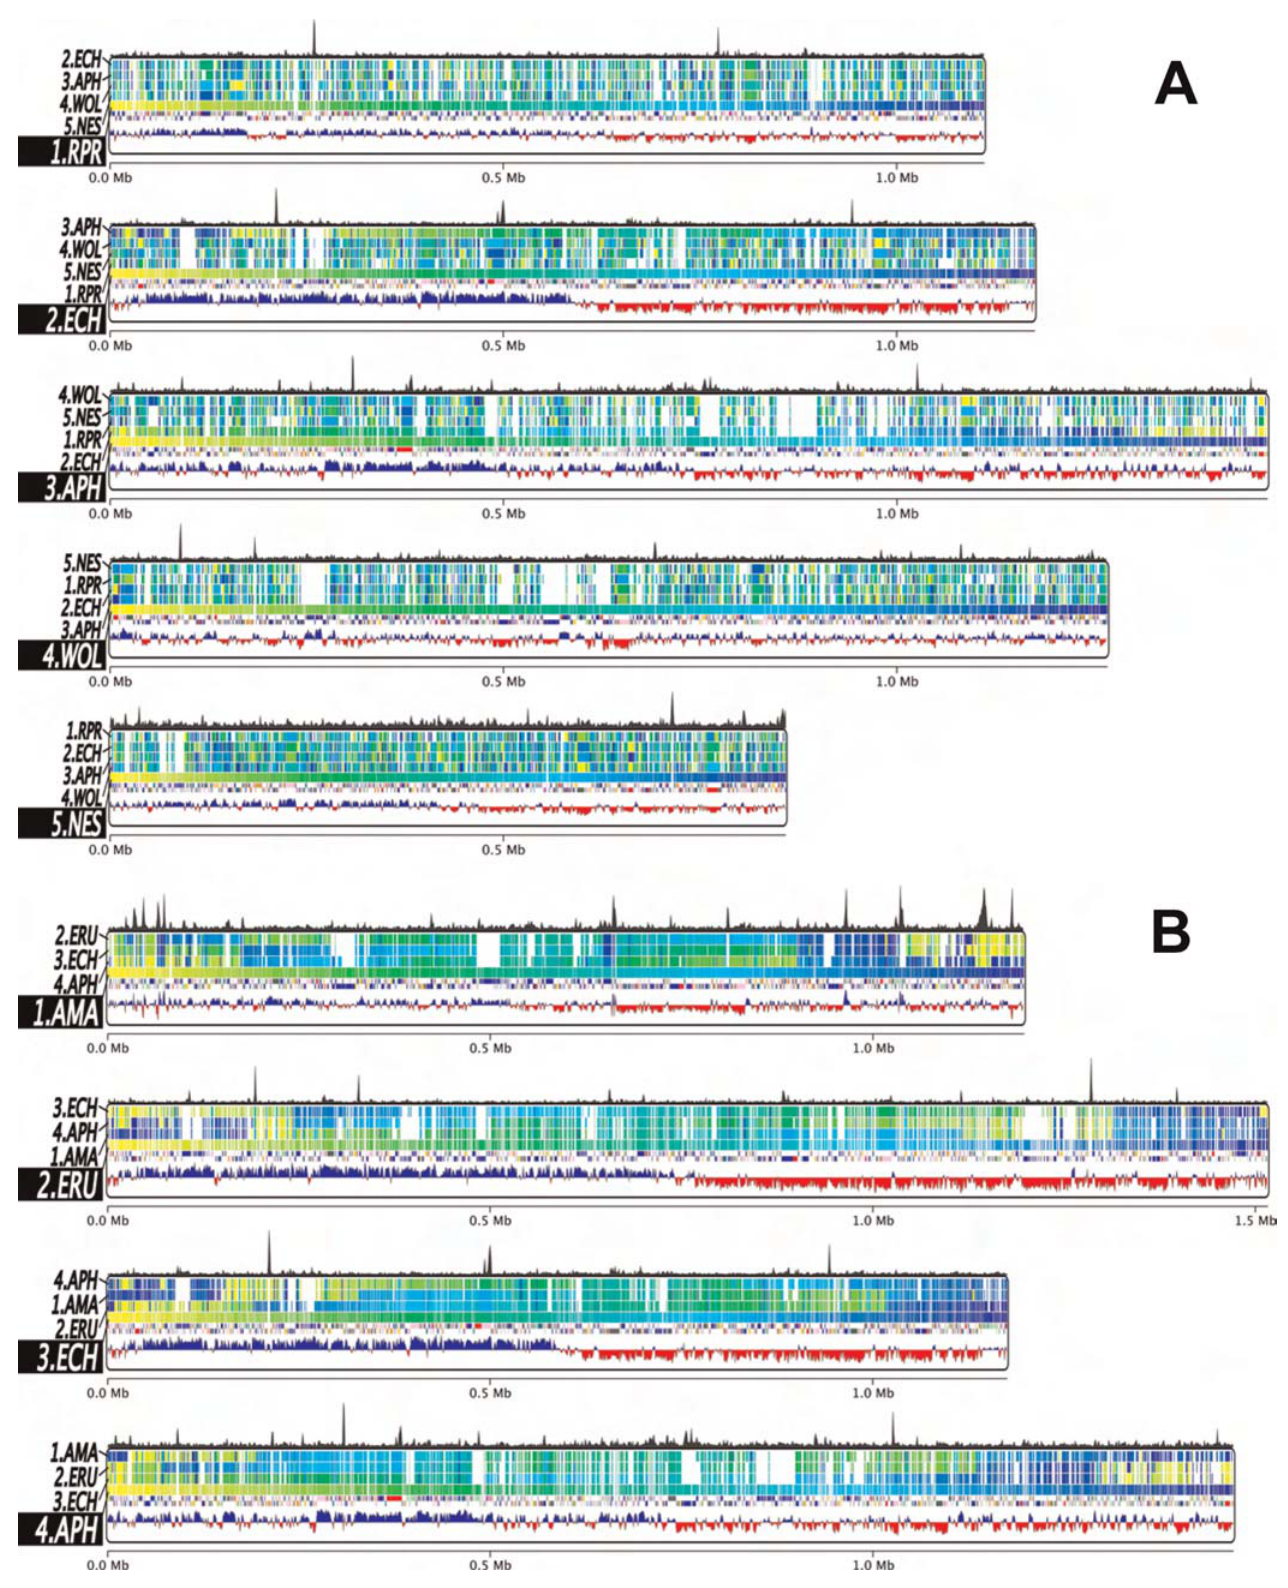
Figure 2. Synteny of the Rickettsiales Regions of conserved synteny were identified using the ortholog clusters (see Materials and Methods) and visualized with Sybil. The genes along each ordered chromosome were colored on a gradient from yellow to blue. The ortholog clusters for each query genome were then plotted relative to the order of the reference genome. Regions of synteny are then seen as continuous gradients across large regions of the genome. Above the synteny gradient display is the atypical nucleotide composition. Below the gradient display are the predicted coding regions on the plus strand and the minus PLoS Genetics |